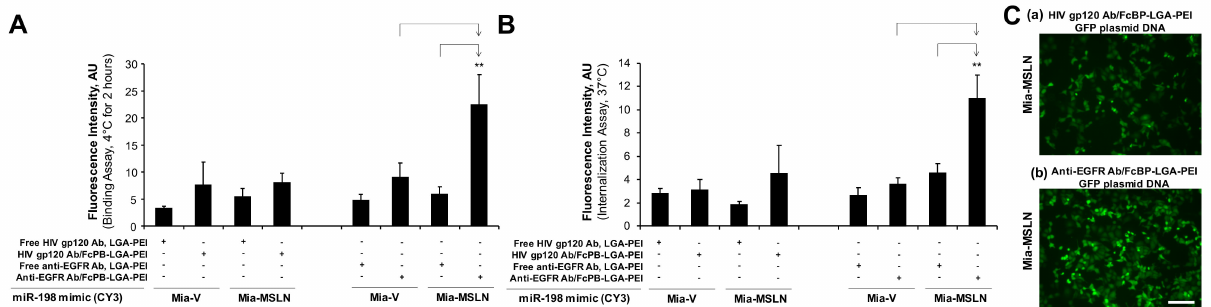
Figure 6. Comparison of specific antibody and non-specific antibody for the targeting delivery of FcBP-LGA-PEI nanoparti- cles (NPs) with miR-198 mimics to specific cells in vitro. ( A ) Cell-binding assay of FcBP-LGA-PEI/miR-198 mimics NPs with different Abs. Mia-MSLN or Mia-vector cells were treated with FcBP-LGA-PEI/miR-198 mimics NPs with anti-EGFR Ab or HIV gp120 Ab. For controls, Mia-MSLN or Mia-vector cells were treated with LGA-PEI/miR-198 mimics with free anti-EGFR Ab or HIV gp120 Ab. All cells were cultured at 4 ◦ C for 2 h before taking images and performing fluorescence intensity analysis ( n = 5). ** p < 0.01. ( B ) Cell internalization assay of FcBP-LGA-PEI/miR-198 mimics NPs with different Abs. Mia-MSLN or Mia-vector cells were treated with FcBP-LGA-PEI/miR-198 mimics NPs with anti-EGFR Ab or HIV gp120 Ab. For controls, Mia-MSLN or Mia-vector cells were treated with LGA-PEI/miR-198 mimics with free anti-EGFR Ab or HIV gp120 Ab. All cells were cultured at 4 ◦ C for 2 h; then, the cells were replaced with fresh culture medium and cultured at 37 ◦ C overnight before taking images and performing fluorescence intensity analysis. ** p < 0.01. ( C ) Targeting delivery of GFP plasmid DNA into Mia-MSLN cells. Anti-EGFR Ab/FcBP-LGA-PEI/GFP plasmid DNA NPs were prepared (details in the Section 4). The NPs were added to 10–15 k Mia-MSLN cells/well growing in 24-well plates and cultured for 24 h. Gene expression was measured by observing GFP-positive cells under a fluorescent microscope. Scale bar (50 µ